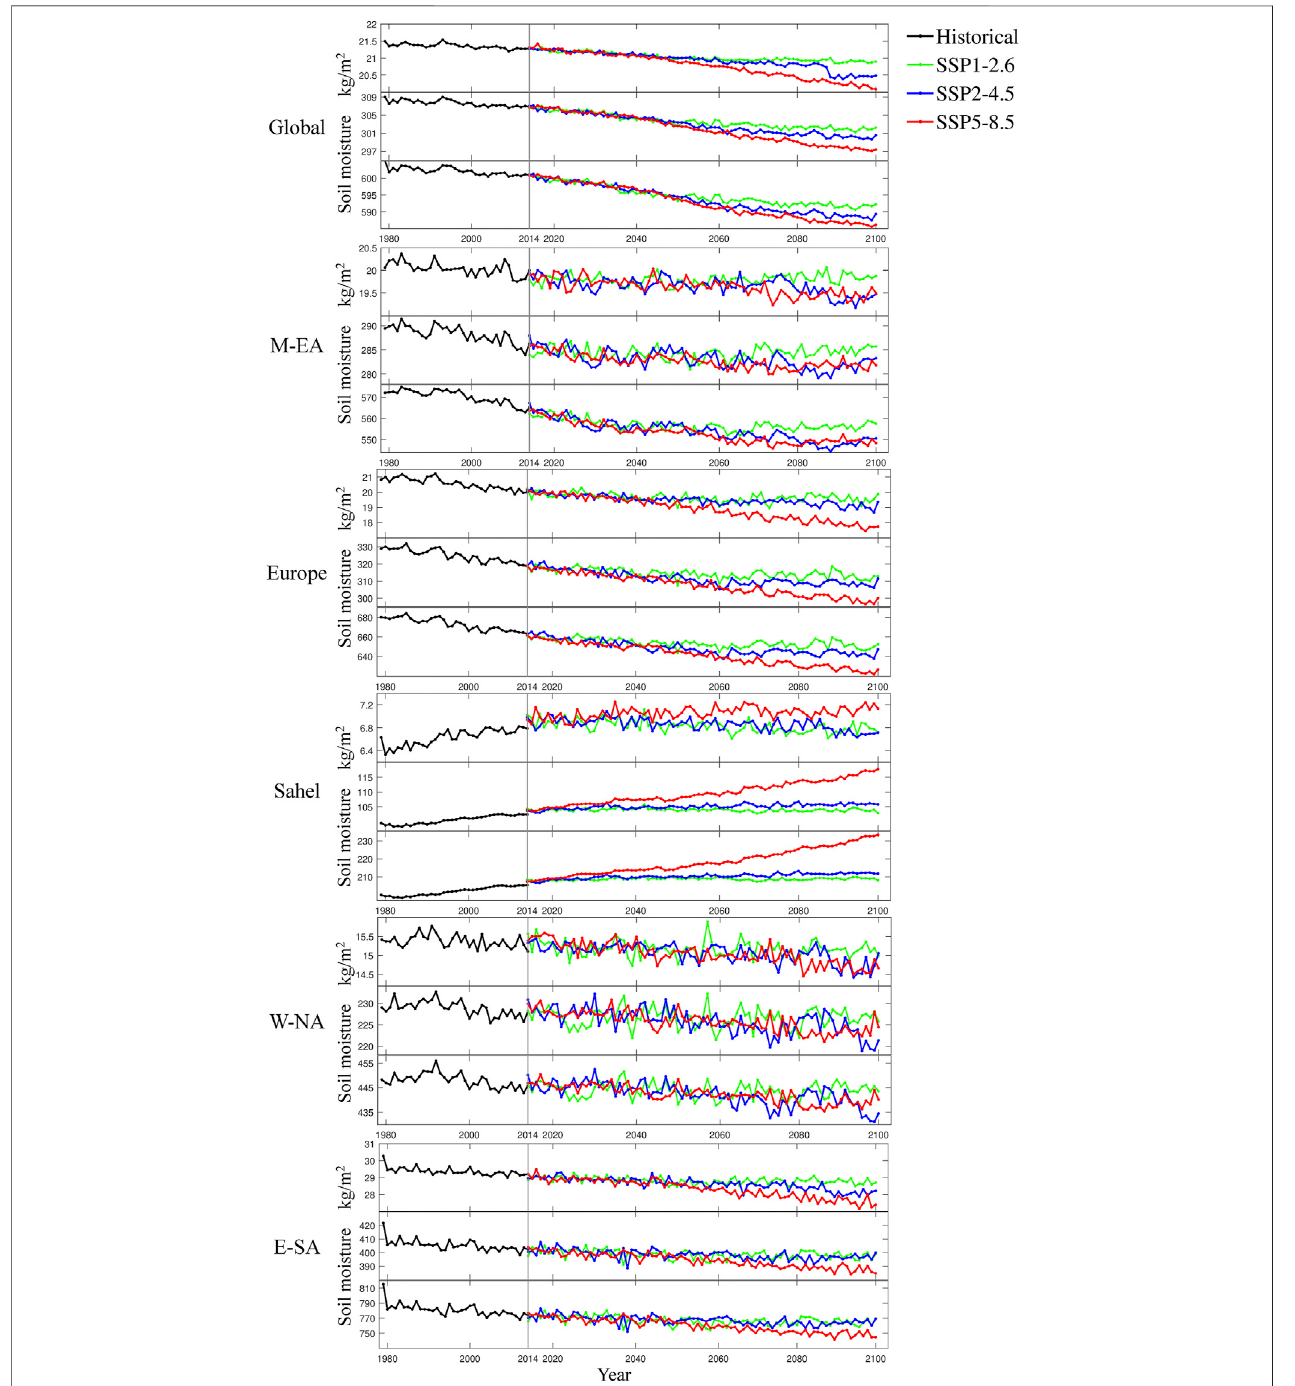
FIGURE 6 | Time series of soil moisture (kg/m 2 ) in the global average and selected hotspots in historical (black line, 1979 – 2014) and different emission scenarios [SSP1-2.6 (green line), SSP2-4.5 (blue line), and SSP5-8.5 (red line), 2015 – 2100]. The M-EA is mid-latitudes of East Asia, the W-NA is Western North America, and the E-SA is Eastern South